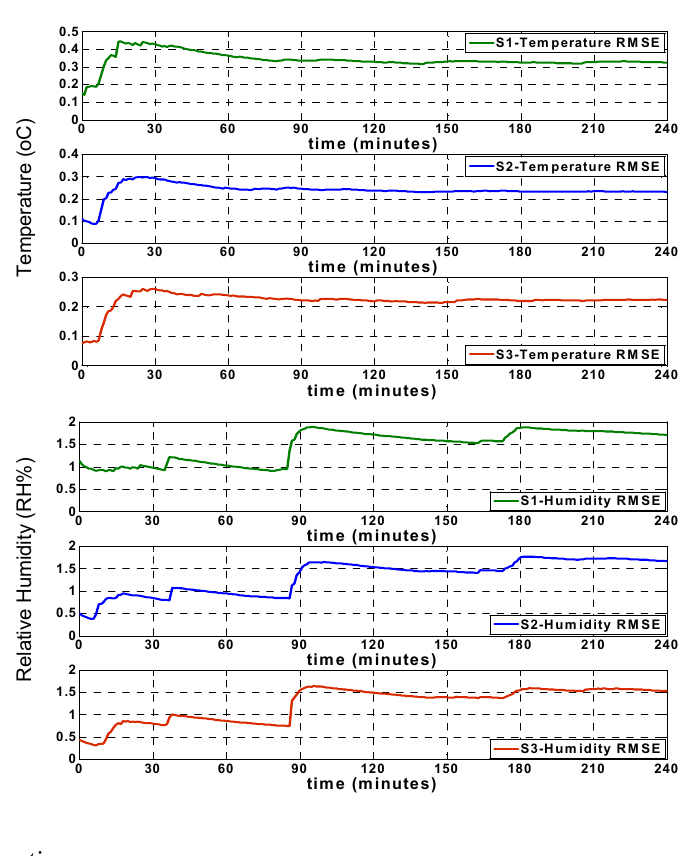
Figure 9. RMSE of LS